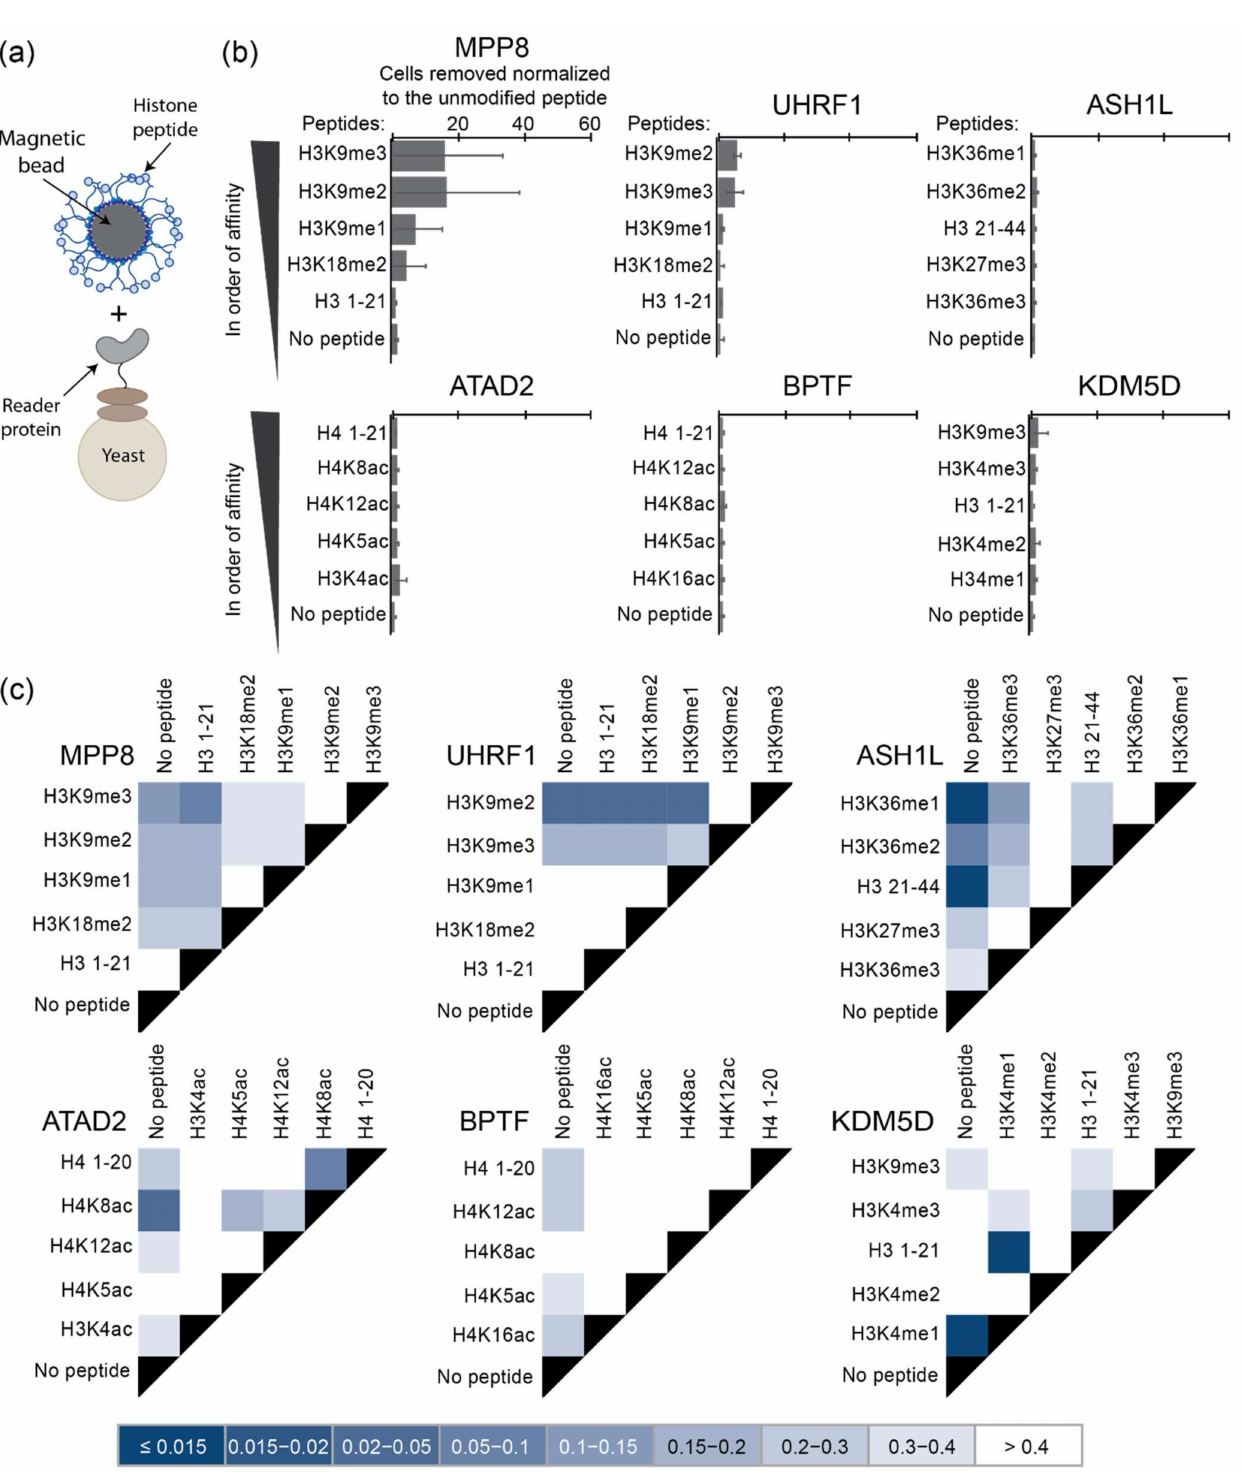
Figure 2. Discrimination of binding specificity and detection of weak binders are abrogated in MACS. ( a ) Interaction between the peptide-coated magnetic beads and the yeast-displaying reader protein. ( b ) Relative amount of yeast-displaying reader proteins magnetically separated by beads linked to modified histone peptides compared to an unmodified histone peptide control; error bars represent the standard deviation from triplicate samples; peptides displayed in order of binding affinity calculated in Figure 1 and from the literature (see Table 1). ( c ) Discrimination between the amounts of yeast separated via magnetization; darker colors are associated with a higher level of discrimination; the legend indicates the p-value comparing each peptide; pairwise comparison via single-factor